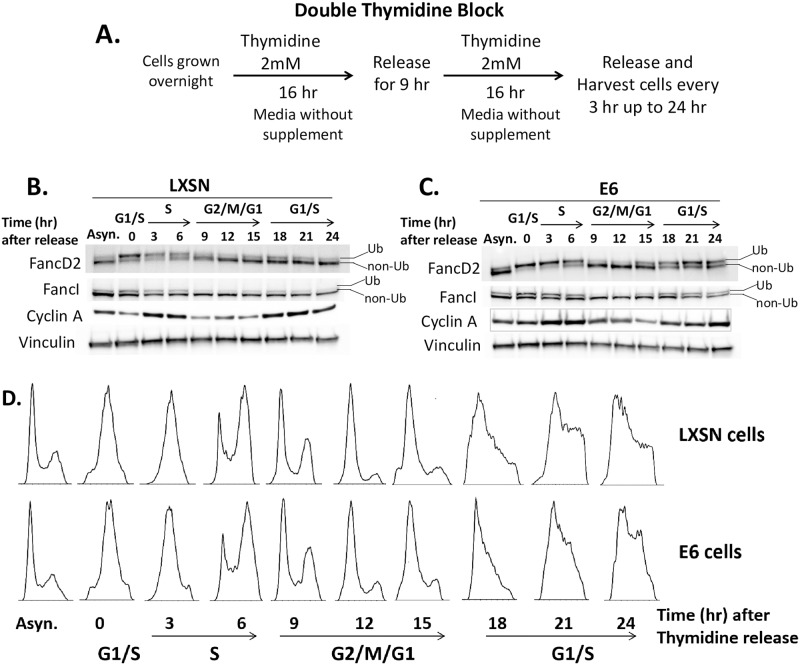
Cell-cycle specific process of FancD2 monoubiquitination/ de-ubiquitination is not abrogated in E6 cells.(A) Outline of synchronization assay in HFK cells using double-thymidine block. Cells were synchronized by double-thymine block and released at various time points. Immunoblot for FancD2, FancI, cyclin A and vinculin of LXSN (B) and E6 cells (C). Cell-cycle phases at each time point were determined by flow cytometry of DNA content (D). Asynchronous (Asyn.) cells, which have not undergone thymidine block, were included for comparison.